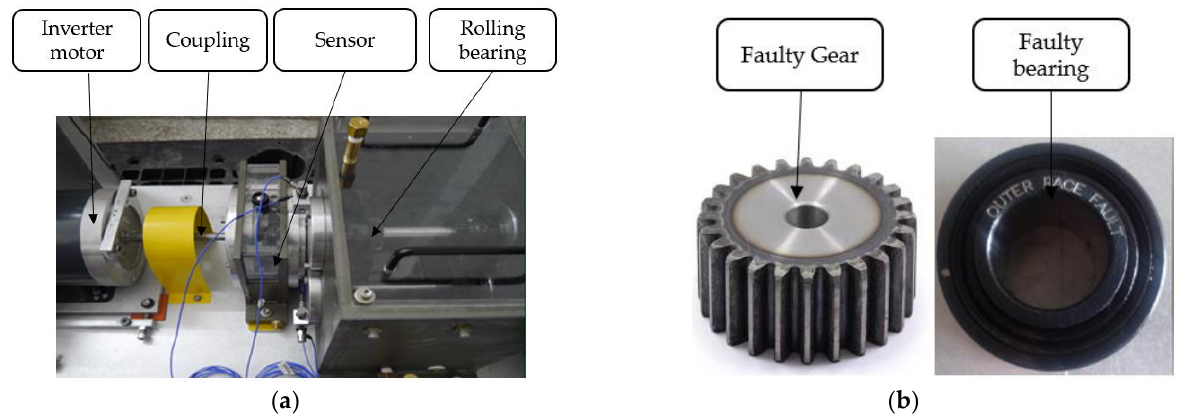
Figure 5. DDS comprehensive test bench and faulty gear. ( a ) DDS comprehensive failure test bench. ( b ) Test bearing.